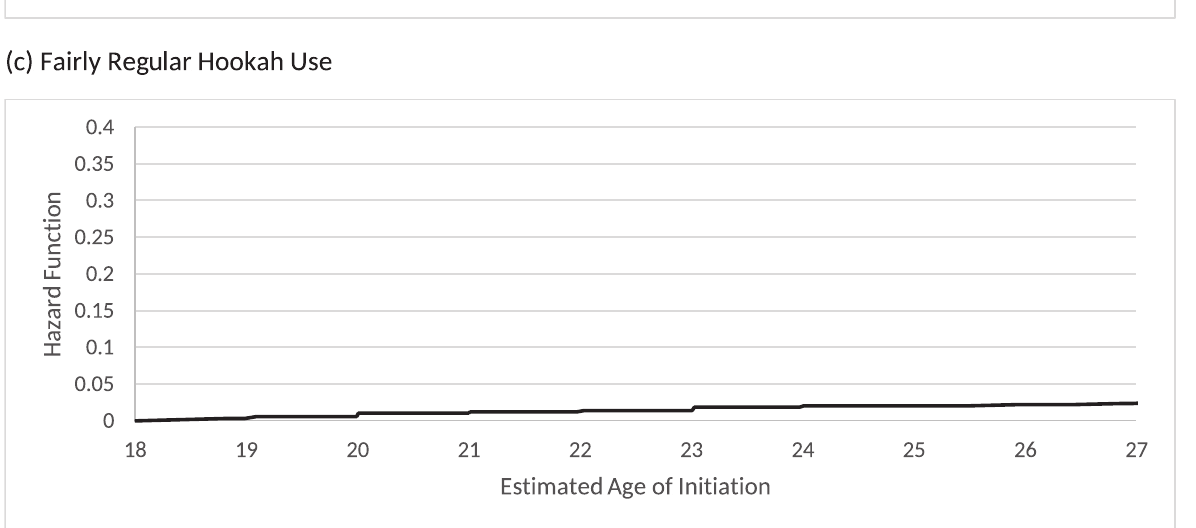
Fig 1. Estimated hazard function of the age of hookah initiation overall.